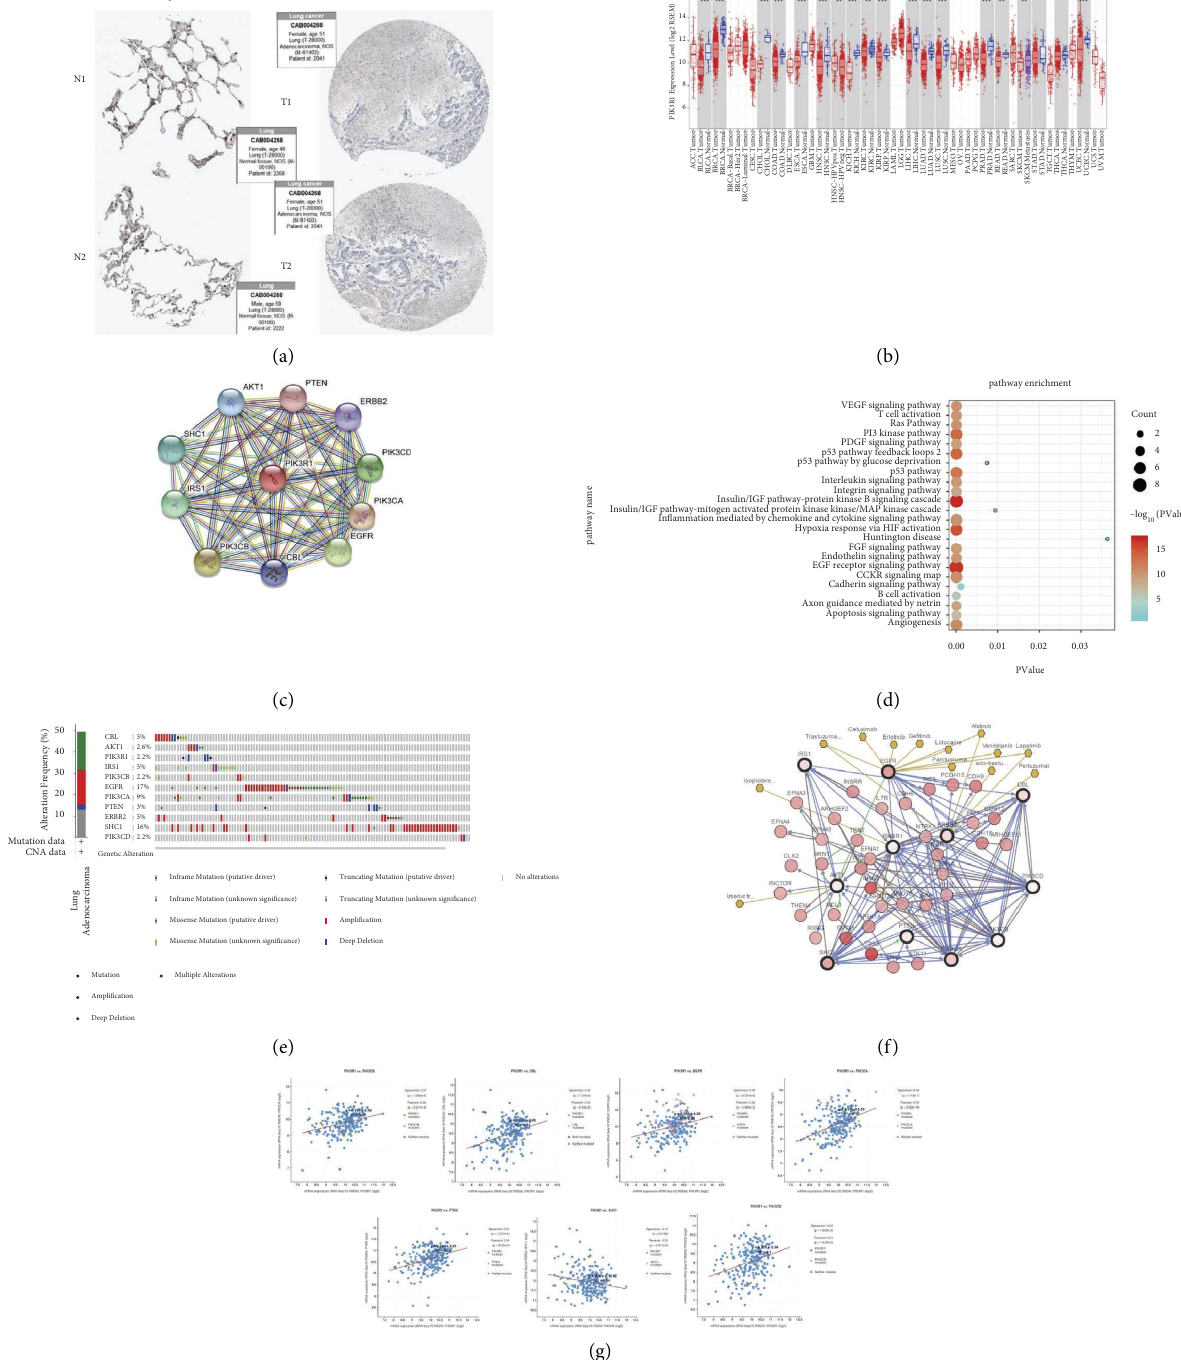
Figure 9: Te biological role of PIK3R1 in tumors. (a) Immunohistochemical analysis of normal lung tissues and lung adenocarcinoma with the HPA online tool, and PIK3R1 was found to be expressed lower in LUAD tissues. (b) Expression of PIK3R1 in various tumors. (c) Interacting proteins for PIK3R1 gene STRING interaction network preview (showing top 10 STRING interactants). (d) Bubble diagram of the PANTHER pathway of PIK3R1 gene. Signifcant pathways with P value < 0.05 and top 24 were plotted by R language. (e) Variation of PIK3R1 related genes in lung adenocarcinoma. (f) Analysis of the network of regulatory pathways of the 11 genes. White is for tumortargeted drugs, and yellow is for oncology drugs approved by the FDA. (g) Te scatter plot showed the correlation between PIK3R1 expression and 7 hub gene